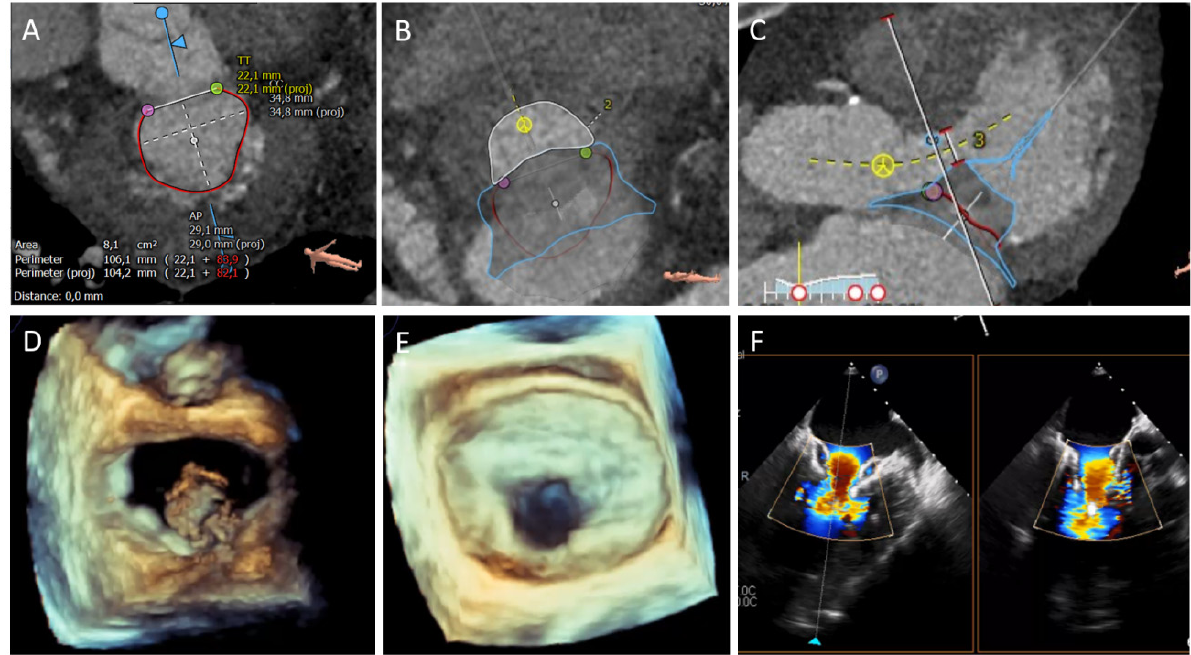
Figure 4. TMVR in native mitral anatomy with Tendyne (Abbott Medical) system. ( A ) Mitral annular dimension assessed with cardiac CT. ( B , C ) Neo-LVOT area after virtual valve implantation with specific Tendyne system design. ( D ) Three- dimensional TEE en-face view of initial THV device deployment and orientation. ( E ) Final result after complete deployment on 3D-TEE and in 2D-TEE color doppler on simultaneous bicommissural and LVOT views ( F ).